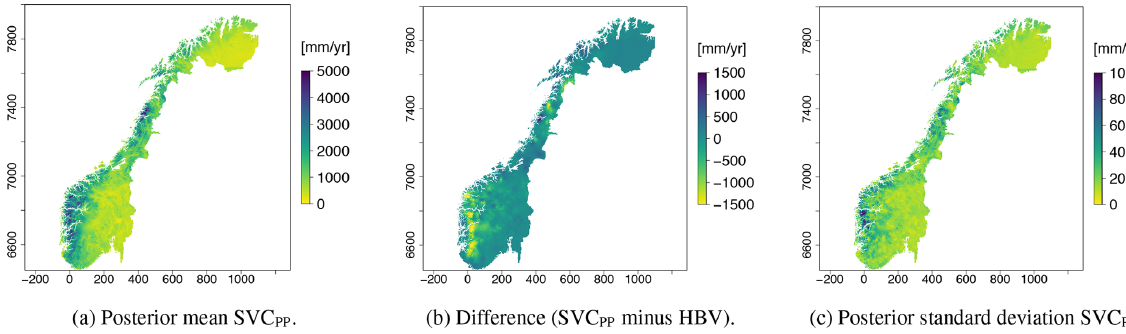
Figure 5. Posterior mean of q( u ) for all grid nodes u (a) , difference between the new map and the original HBV map (new–old, b ) and posterior standard deviation of q( u ) (c) .